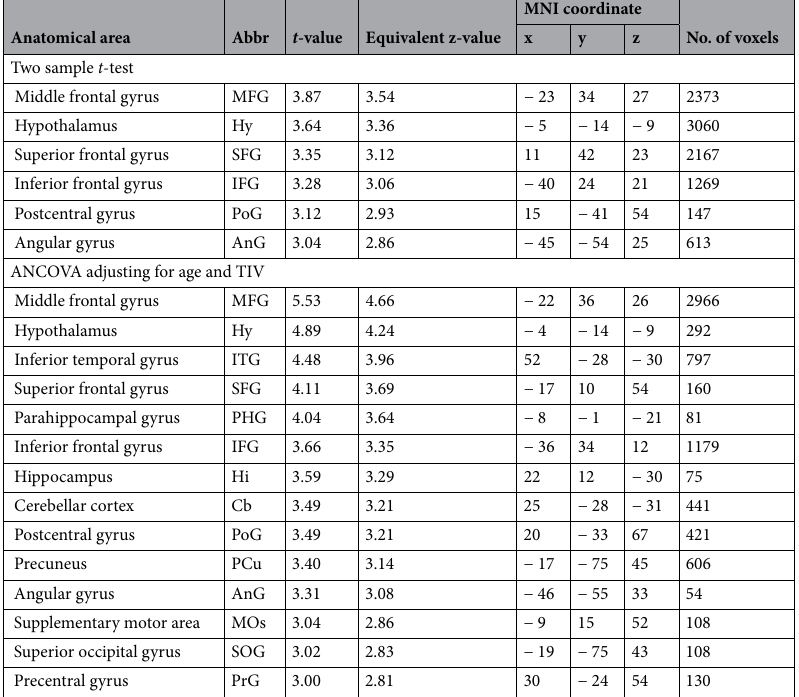
Table 3. Larger GM volume areas in MHT group ( p < 0.05; threshold t -value 3.0 and cluster size more than 50 pixels). MNI Montreal Neurological Institute, ANCOVA analysis of covariance, TIV total intracranial volume.